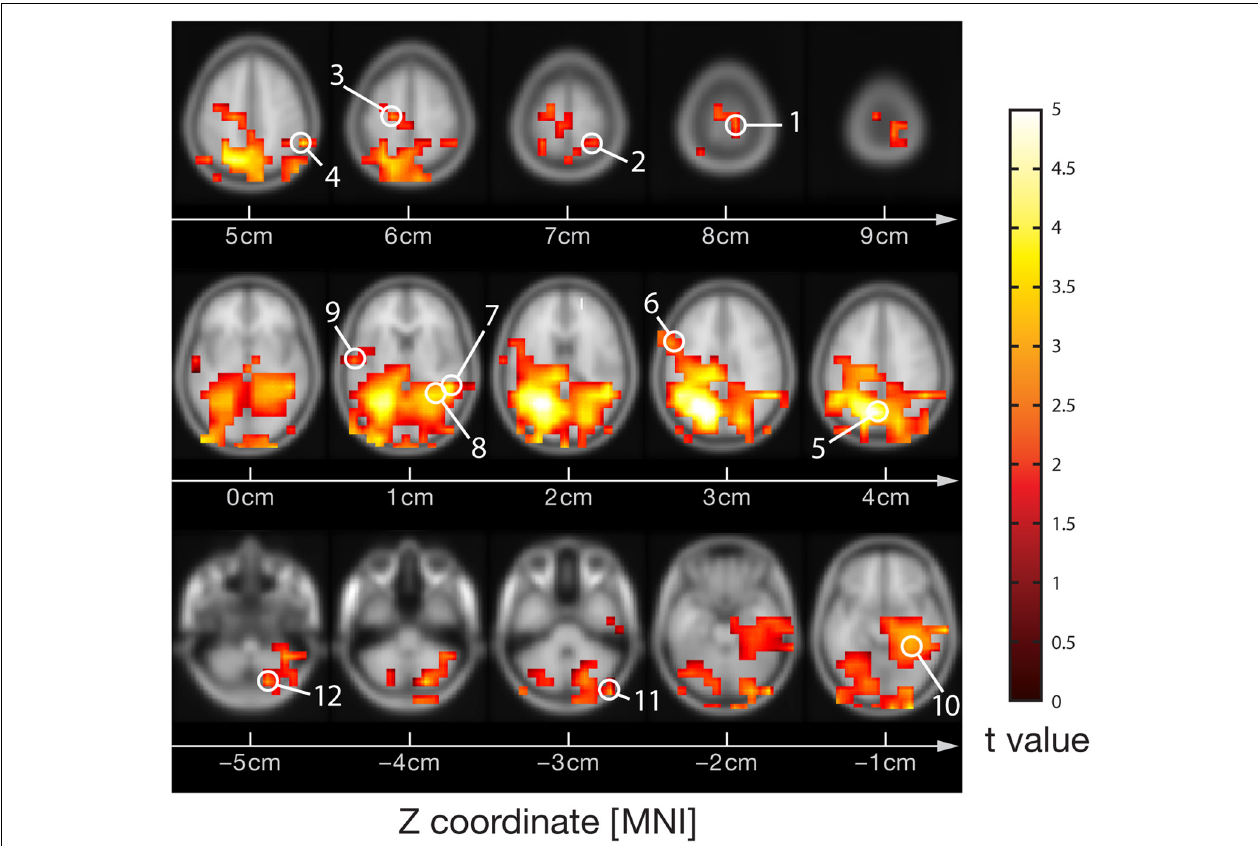
FIGURE 1 | MEG-beamformer source locations used for the analysis of active information storage. MEG sources with enhanced power in the high-frequency gamma band (60–120Hz) upon visual stimulation with Mooney face images (see Grützner et al., 2010 for stimulus details); permutation test on t -metrics p < 0 . 05, cluster-based correction for multiple comparisons. Source locations: 1—Primary motor cortex BA4a R (10, − 30, 80), 2—Superior parietal lobule 7PC R (30, − 50,